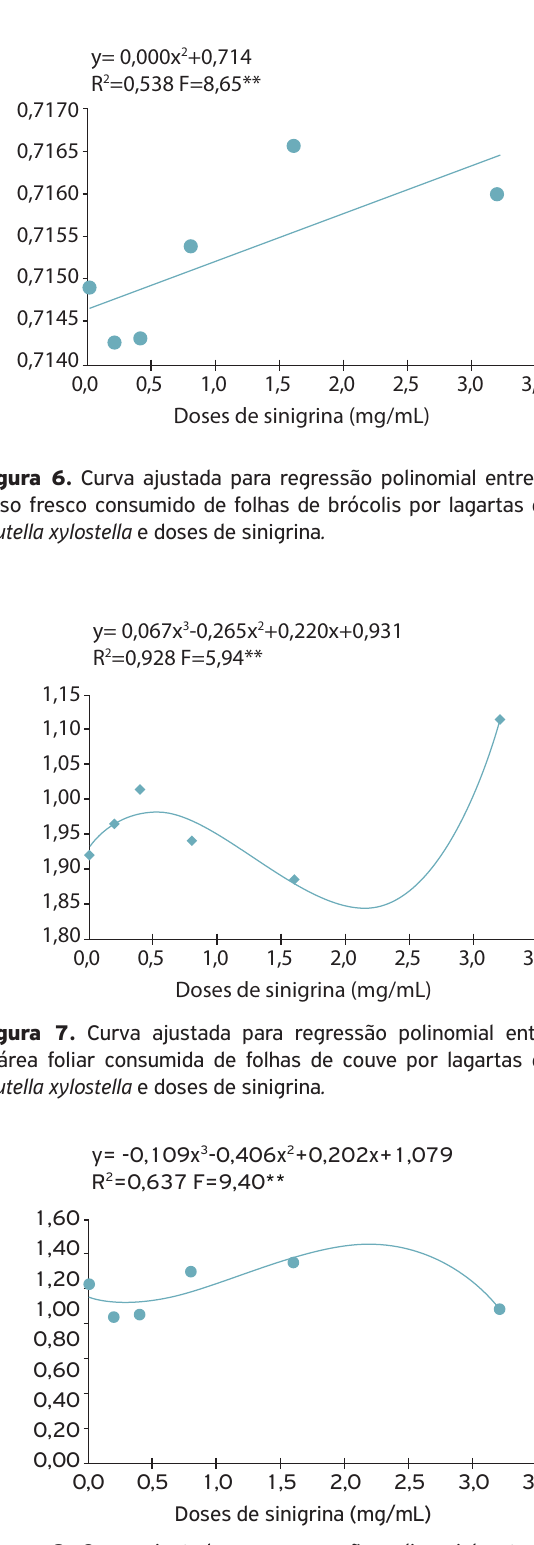
Figura 8. Curva ajustada para regressão polinomial entre a área foliar consumida de folhas de brócolis por lagartas de Plutella xylostella e doses de